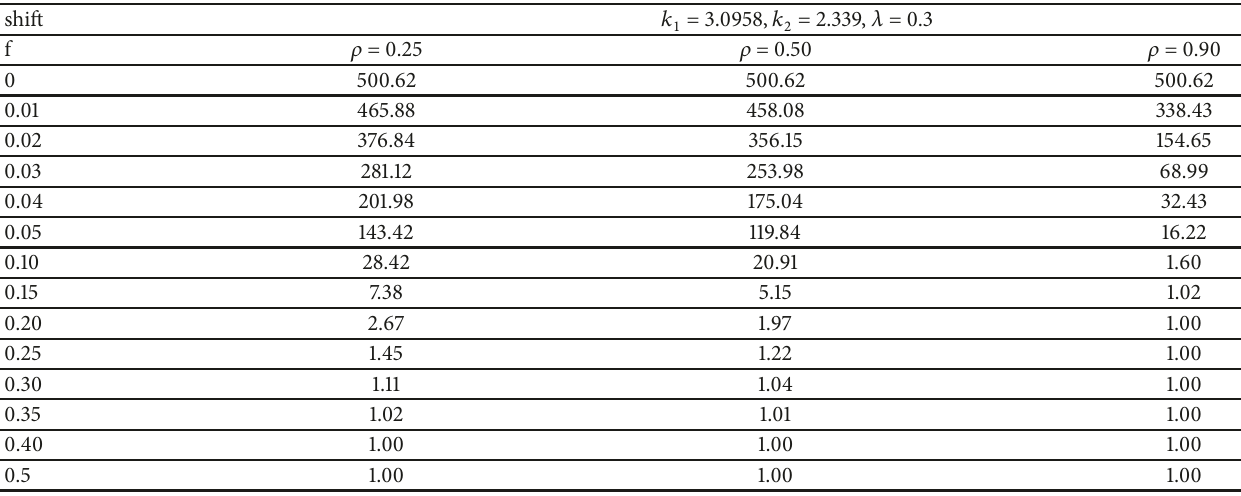
Table 9: ARLs for proposed repetitive EWMA-RSS control chart using Khan et al. [8] exponential ratio-type estimator, when 𝑟 𝑜 is 500. shift